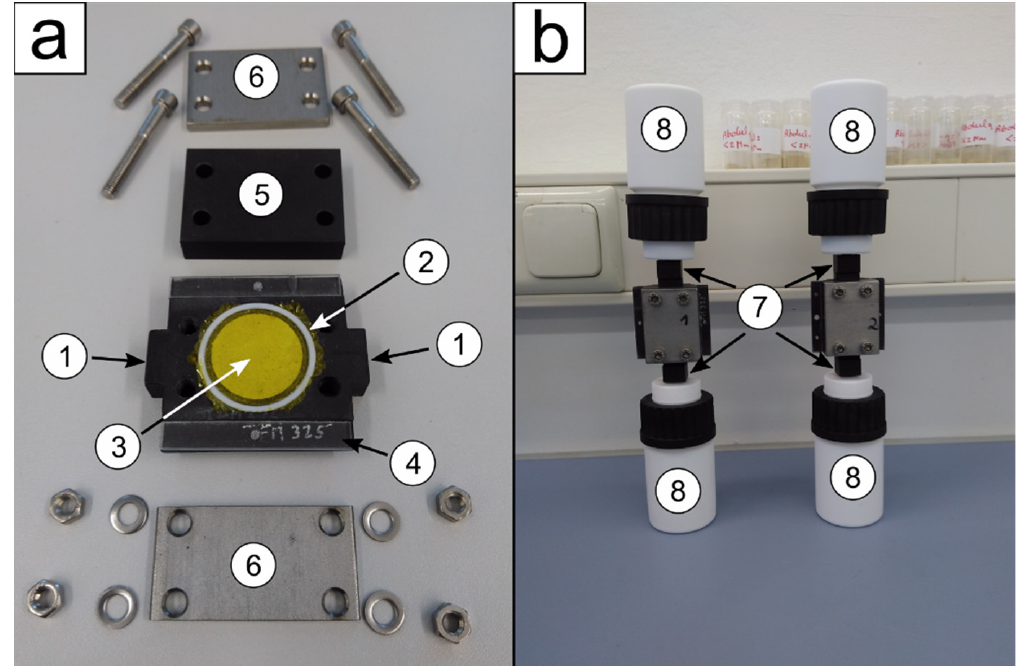
Figure 1. ( a ) Overview of the components of the wet cell. ( b ) Assembled wet cell assemblage. (1) Threaded inlets on each side of the cell. (2) Teflon O-ring seal. (3) Kapton foil (7.5 µm thick) used for sealing the sample chamber containing the compacted SD80 bentonite powder. (4) Modification bracket to mount the wet cell on the Bruker D8 Advance stage. (5) Teflon cover. (6) Metal plates and screws used to seal the cell with the Teflon cover to maintain a confined volume system. (7) Adaptors used to connect the wet cell and the Teflon bottles. (8) Teflon bottles to supply and capture the percolating solution.